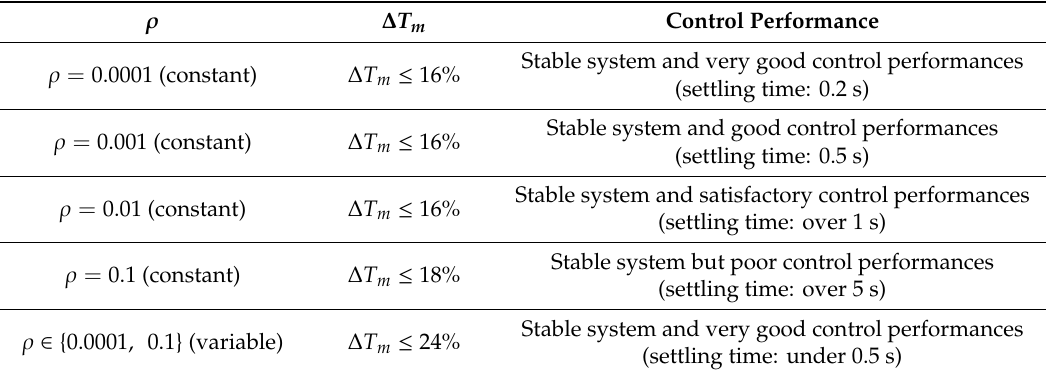
Table 1. The case studies—results for maximum allowed values of mechanical torque variation ( ∆ T m ). ρ ∆ T m Control Performance ρ = 0.0001 (constant) Stable system and very good control